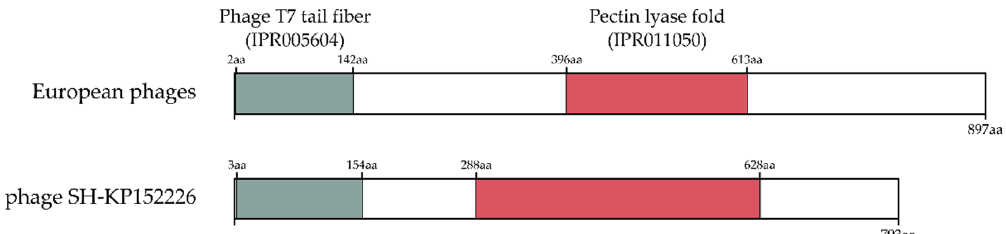
Figure 4. Comparison of tail fiber protein of the European R. solanacearum phages vRsoP-WF2, vRsoP-WM2 and vRsoP-WR2 (ORF 48 in vRsoP-WF2 and vRsoP-WM2, and ORF 49 in vRsoP-WR2) (coding for proteins of 897 aa) and the K. pneumoniae phage SH-KP152226 (ORF 42, coding for a protein of 793 aa). Grey and red regions correspond to phage T7 tail fiber (IPR005604) and pectin lyase fold/virulence (IPR011050) conserved domains, respectively.